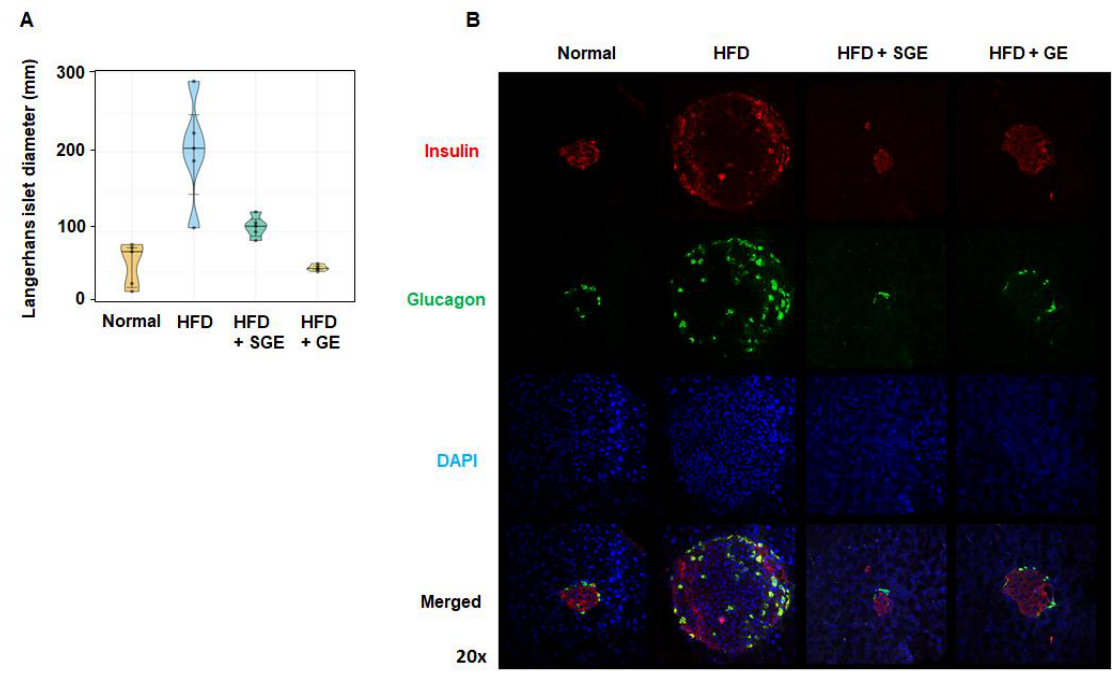
Figure 3. Korean red ginseng prevents HFD-induced increase of pancreatic islet size. ( A ) Langerhans islet diameter (mm) ( n = 5/group) and ( B ) pancreatic cells expressing insulin and glucagon. Magnification 20×.